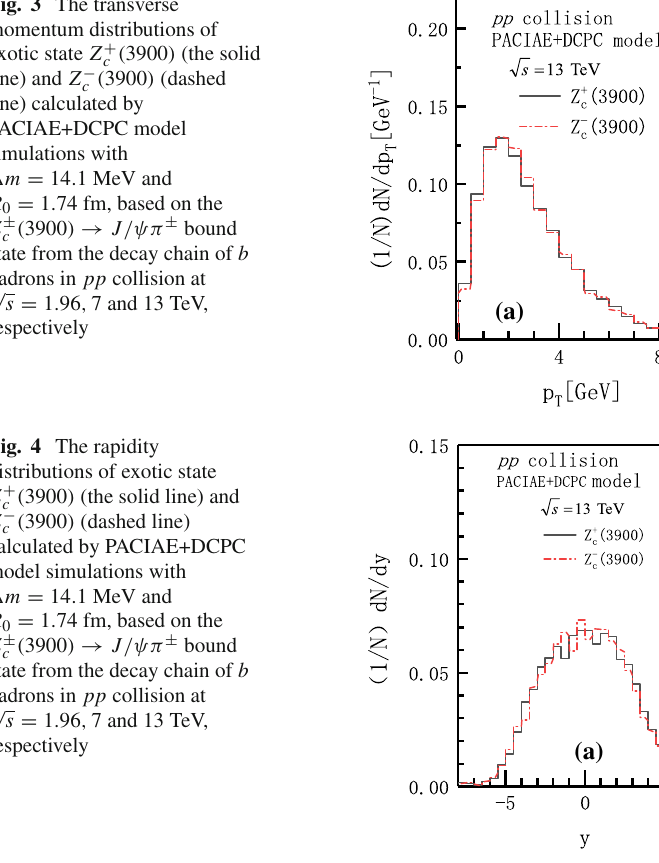
Fig. 3 The transverse momentum distributions of exotic state Z + c ( 3900 ) (the solid line) and Z − c ( 3900 ) (dashed line) calculated by PACIAE+DCPC model simulations with (cid:5) m = 14 . 1 MeV and R 0 = 1 . 74 fm, based on the Z ± c ( 3900 ) → J /ψπ ± bound state from the decay chain of b hadrons in pp collision at √ s = 1 . 96 , 7 and 13 TeV, respectively